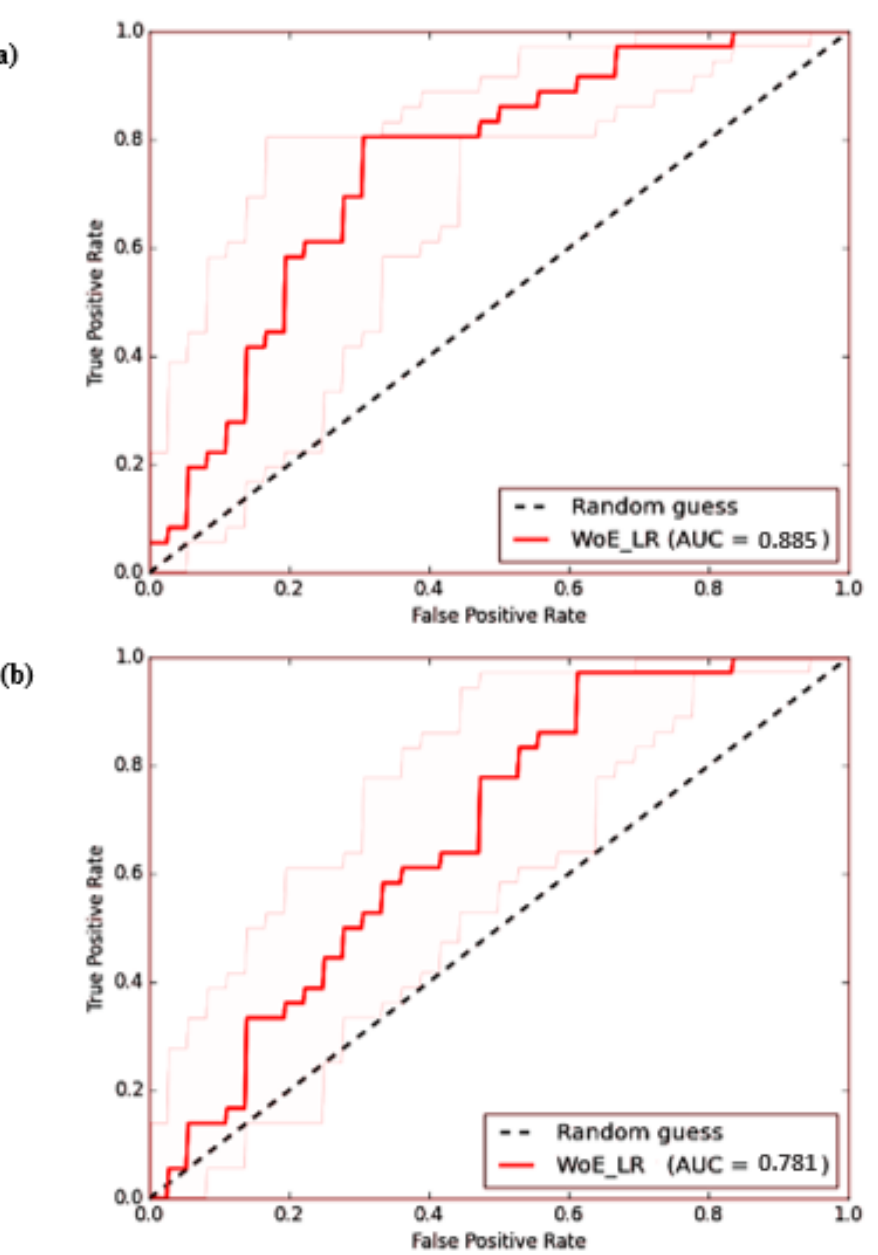
Figure 12. Prediction rate curve for gully erosion susceptibility map using WoE–LR in Kakia- Esamburmbur catchment: ( a ) training and ( b ) validation.